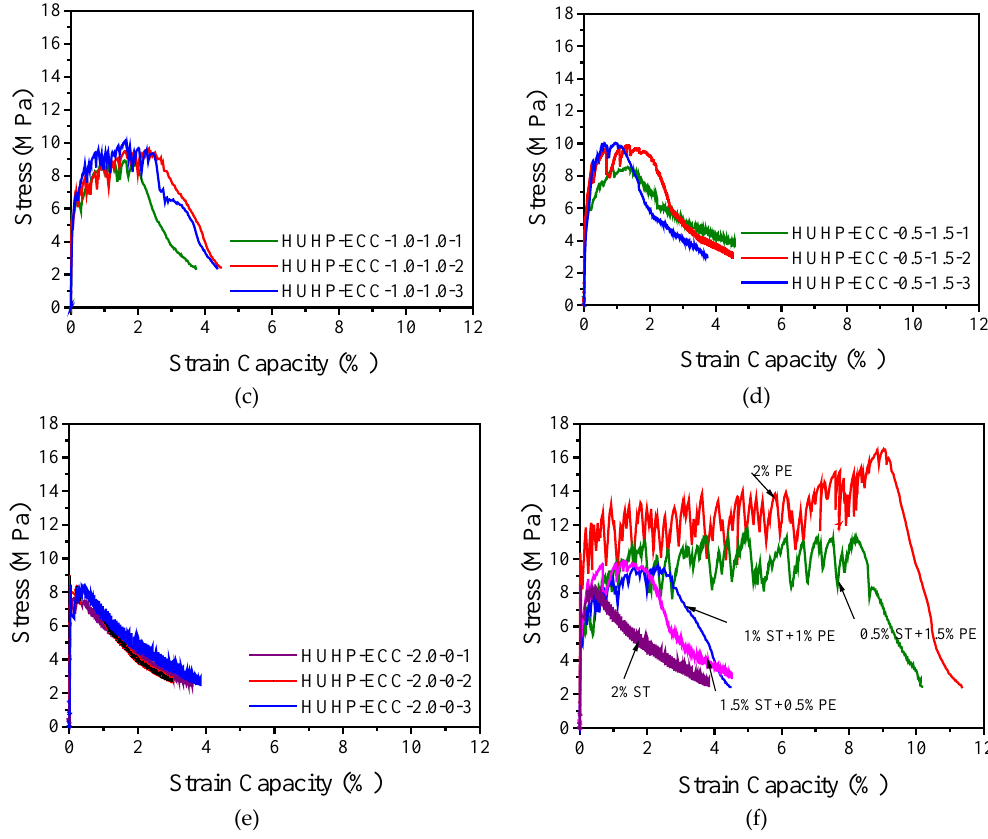
Figure 7. Tensile stress-strain curves of HUHP-ECCs. ( a ) HUHP-ECC-2.0-0; ( b ) HUHP-ECC-1.5-0.5; ( c ) HUHP-ECC-1.0-1.0; ( d ) HUHP-ECC-0.5-1.5; ( e ) HUHP-ECC-0-2.0; ( f ) Stress strain capacity of different volume fractions of PE and ST fibers.